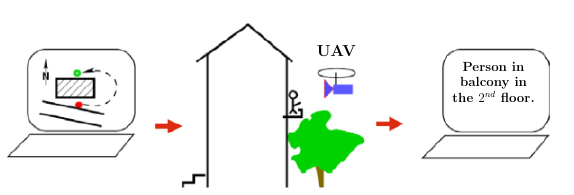
Person in balcony in the 2 nd floor.